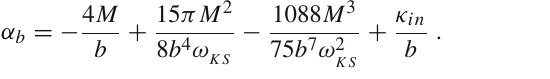
Fig. 5 Inhomogeneous case: In the first two rows, we show the depen- dence of the deflection angle of photon with dimensionless impact parameter ( b / M ) for various combinations of dimensionless “Hoˇrava” parameter( ˜ ω )andplasmaparameter.Inthethirdrow,thedependence KS